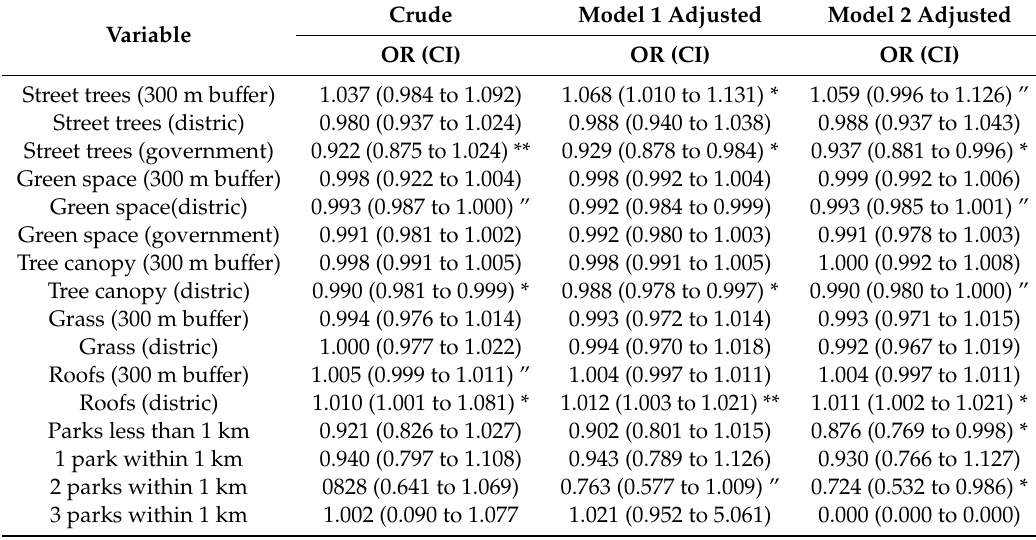
Table 3. Odds ratios (and 95% confidence intervals) for the association between hypertension diagnosis, land cover and green space